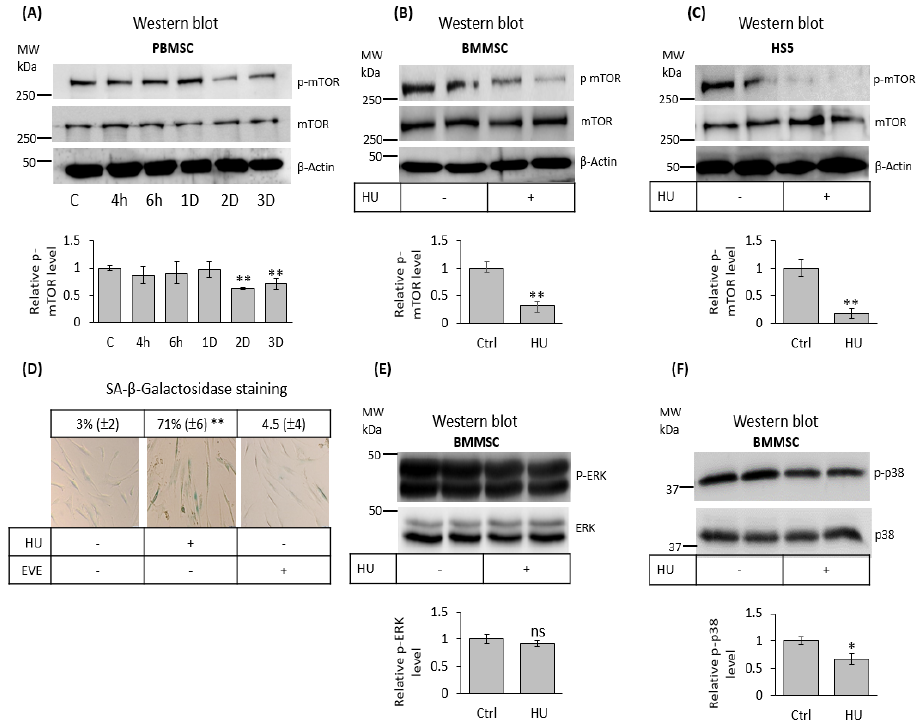
Figure 6. Hydroxyurea inhibits mTOR activation in MSC. ( A ) PBMSC were treated for the indicated period of time with 200 μ M HU and subjected to mTOR phosphorylation analysis by Western blot. ( B , C ) BMMSC and HS ‐ 5 cell line treated for three days with 200 μ M of HU and subjected to mTOR phosphorylation analysis by Western blot. Top tables indicated the relative densitometry values for the obtained signals. α‐ actin is determined as loading control. ( D ) BMMSC were three days treated with 200 μ M of HU or 100 nM Everolimus (EVE) and subjected to SA ‐β‐ gal histochemistry assay. ( E , F ) BMMSC and HS ‐ 5 cell line were treated for three days with 200 μ M of HU and subjected for ERK1,2 and p38 MAPK phosphorylation analysis by Western blot assay. n = 3, mean ± SEM, p < 0.05 (*) and p < 0.005 (**).